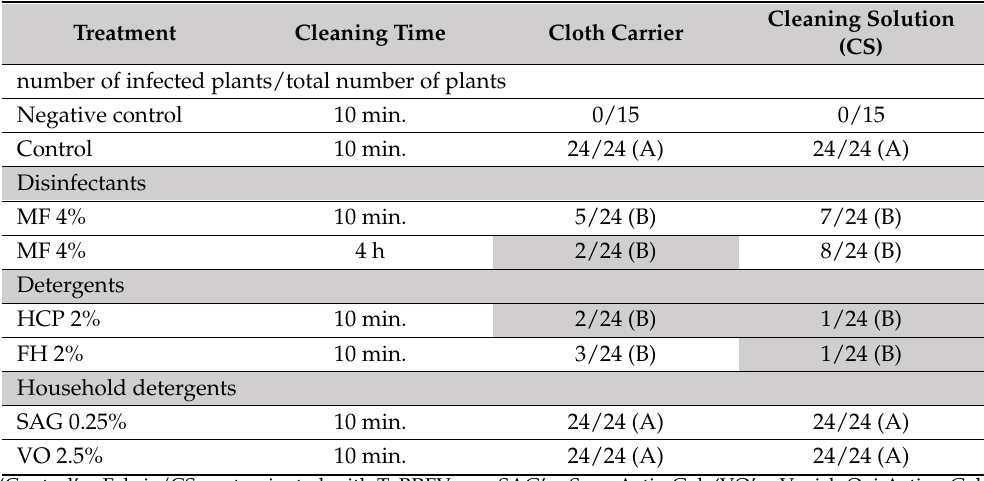
Cleaning Solution (CS)